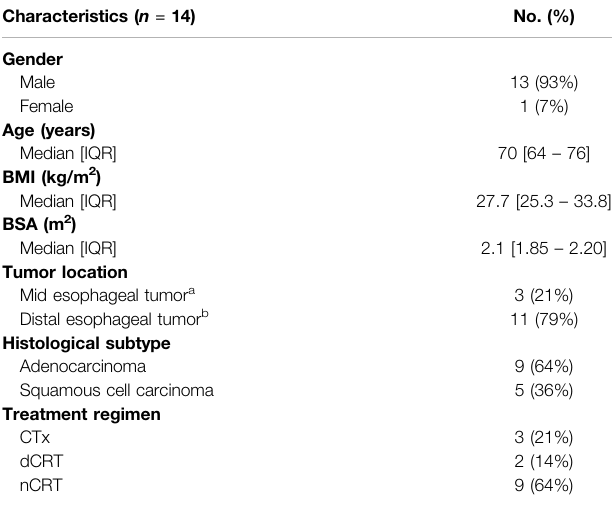
TABLE 1 | Baseline